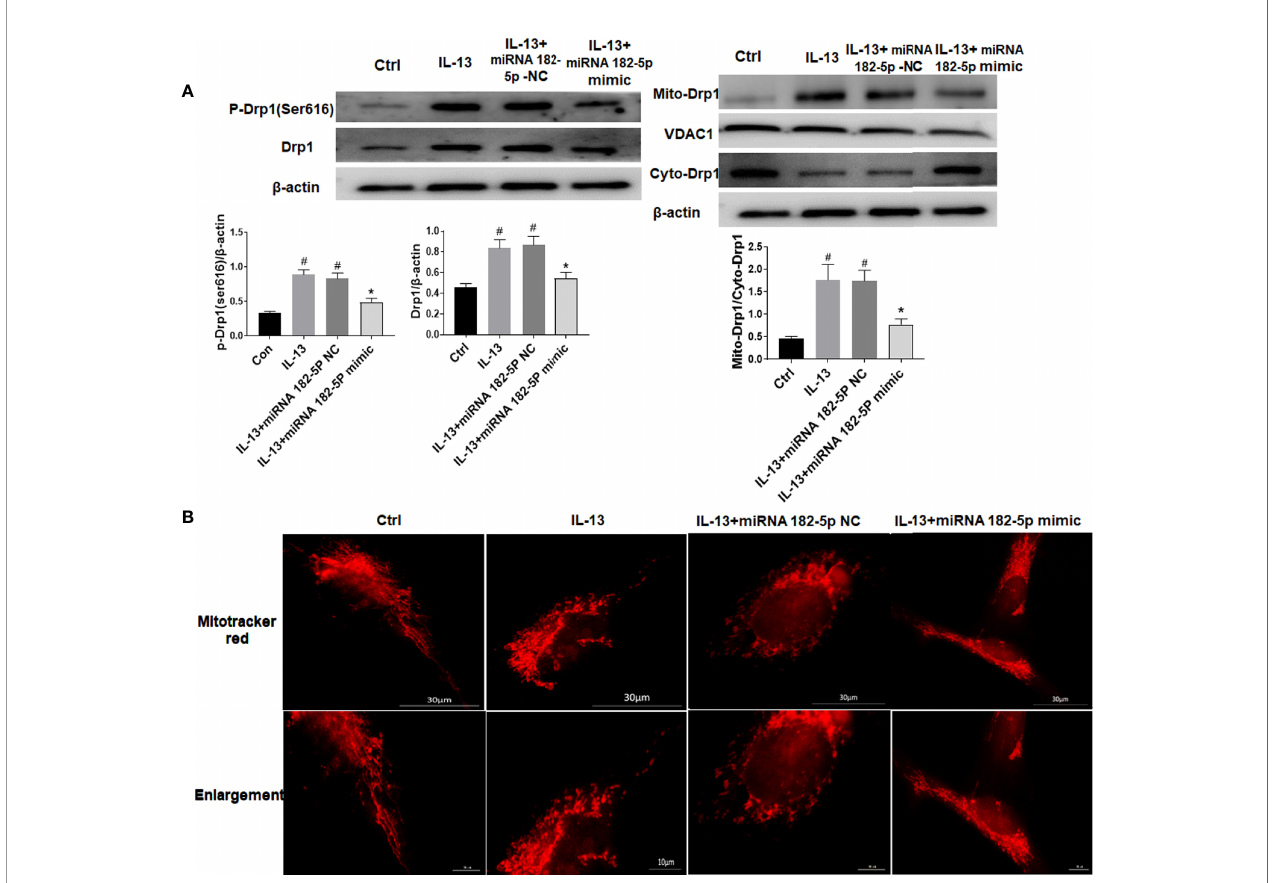
FIGURE 5 | MiRNA-182-5p is involved in the regulation of mitochondrial morphology. (A) MiRNA-182-5p mimic or NC was used to intervene before IL-13 stimulation of BEAS-2B cells, and the expression of Drp1 and p-Drp1 (Ser616) was measured by Western blot. Drp1 translocation was observed by measuring the expression of Drp1 in the cytoplasm and mitochondria; (B) Mitochondrial morphological changes were observed by MtioTracker Red staining, Scale bar: 30 µm. All data were shown as mean ± SD (n = 3). # p < 0.05 versus control, * p < 0.05 versus IL-13 group as determined by one-way analysis of variance (ANOVA) and Dunnett ’ s post hoc